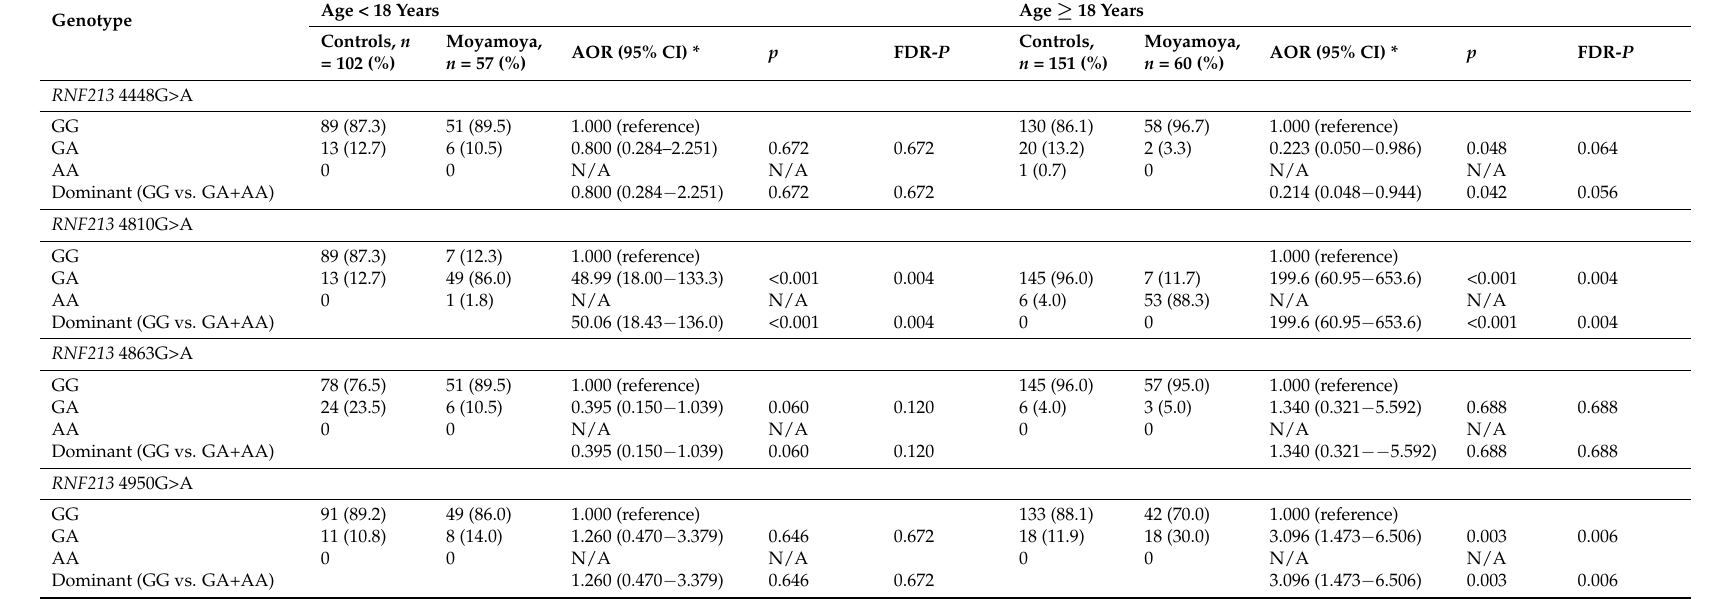
Table 4. The frequencies of the RNF213 polymorphisms according to